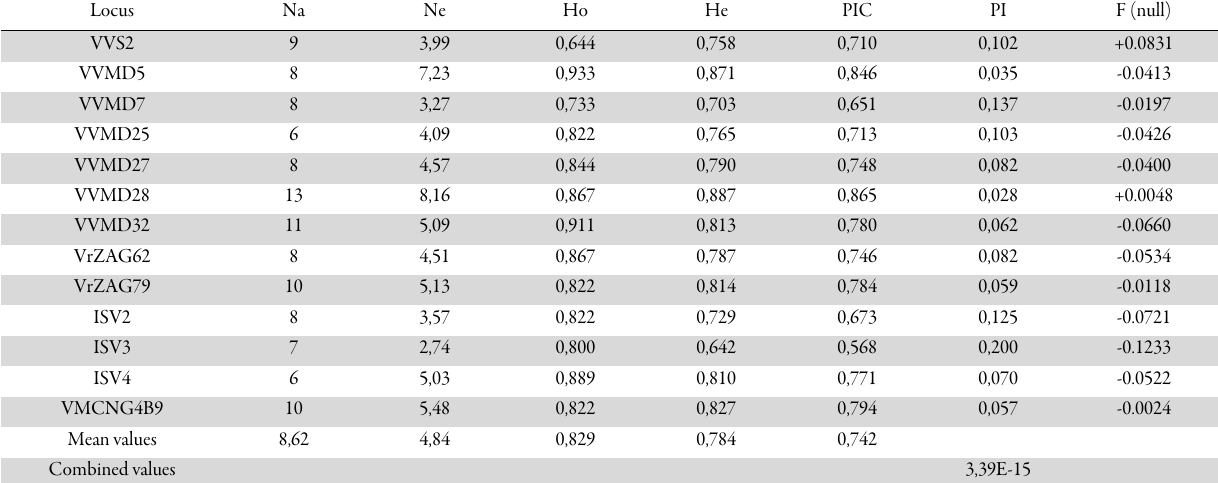
Table 2. Genetic markers (13 microsatellite loci) and parameters applied to analyze their effectiveness to highlight genetic variability from the grapevine germplasm